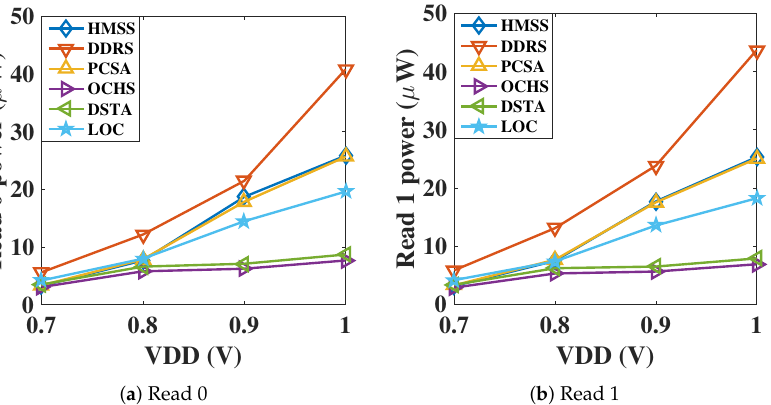
Figure 6. The dynamic sensing power consumption of different sensing circuits with ( a ) reading 0 and ( b ) reading 1. Due to the triple paths structure, the dynamic power dissipation of our proposed HMSS-SA is greater than OCHS but less than